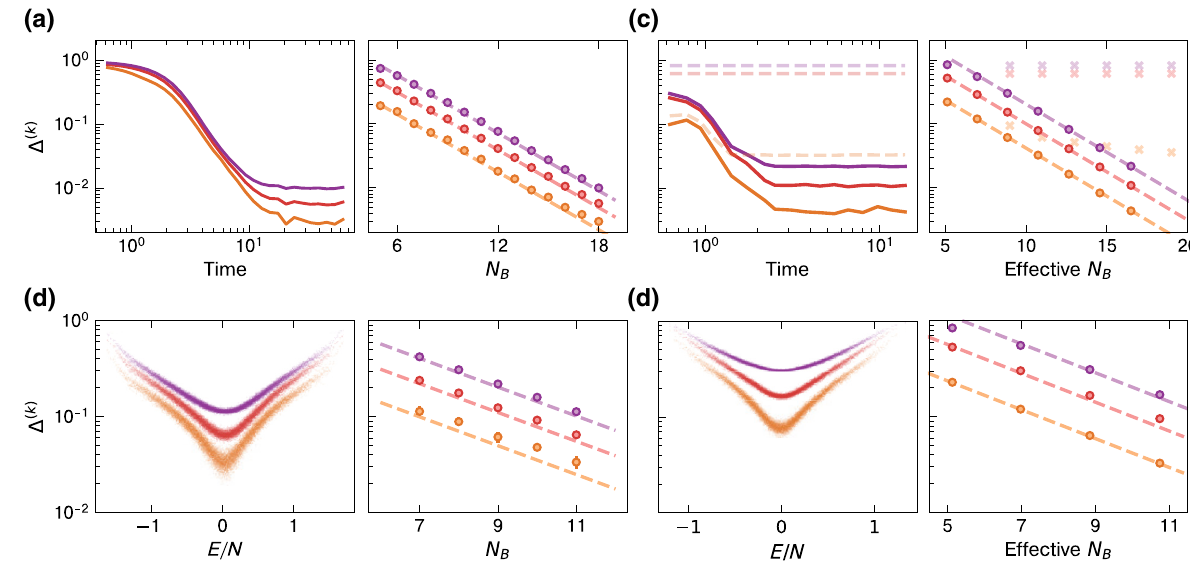
FIG. 7. Emergent quantum state designs in random-coupling and random-hopping models. (a),(b) The time-evolution (a) and eigen- state (b) data for the random all-to-all coupling model in Eq. (C2). The trace distances (cid:10) ( k ) for k = 1, 2, and 3 are plotted in orange, red, and purple, respectively, for N A = 3 subsystems [(a), left]. The time-evolution data for N = 21 are plotted, along with the system-size scaling of the late-time (cid:10) ( k ) for N = 8 to 21 [(a), right]. We also plot (cid:10) ( k ) for each eigenstate for N = 14 [(b), left], along with the system-size scaling of the eigenstate data near E = 0 for N = 10 to 14 [(b), right]. (c),(d) The time-evolution (c) and eigenstate (d) data = 0 sector. In (c), time-evolution for the random-hopping model in Eq. (C3). Data are presented for N A = 5 subsystems, in the S z tot. data for N = 24 are plotted along with system-size scaling for N = 10, 12, . . . , 24. To illustrate the failure of projecting onto all strings z B , we plot the results of this naive procedure with N A = 3 in light colors and dashes. In (d), eigenstate data for N = 16 are plotted, along with their system-size scaling for N = 12, 14, 16 and 18. The system-size scaling is plotted against the effective N B , which is of the number of strings z B and which is postselected. In each plot, the error bars are smaller than the marker log 2